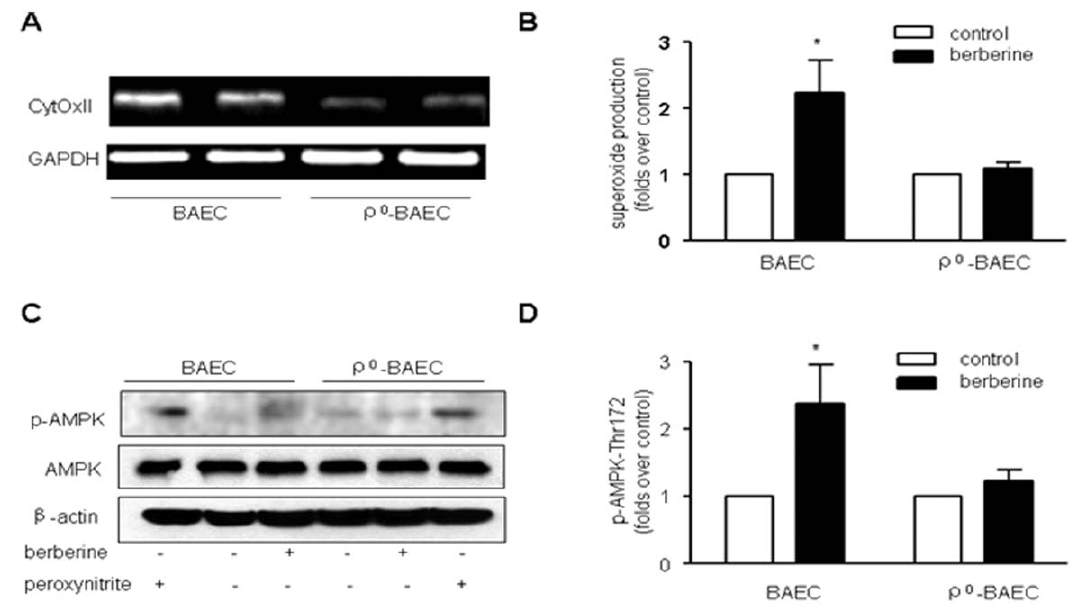
Figure 5. Mitochondria depletion abolishes Berberine-induced AMPK phosphorylation in endothelial cells. Confluent monolayers of BAEC were incubated in EGM with 2% fetal bovine serum alone or in r u medium as described in ‘‘Materials and Methods.’’ A , After incubation, BAEC were harvested, total RNA were extracted, and mRNA for cytochrome c oxidase subunit II (CytOxII) were estimated by RT-PCR. Data are representative of three independent experiments. B , BAEC and r u cells were treated with Berberine (10 m M) for 30 min; the production of ROS was detected by DHE/ HPLC assay. C & D . Effects of mitochondria depletion on AMPK-Thr172 phosphorylation caused by Berberine and ONOO-. BAEC and r u cells were treated with Berberine (10 m M) for 2 h or ONOO 2 (50 m M) for 15 min, after treatment, cells were lysed and proteins were separated by SDS-PAGE and Western blots. n=3 * p , 0.05, control versus Berberine-treated.